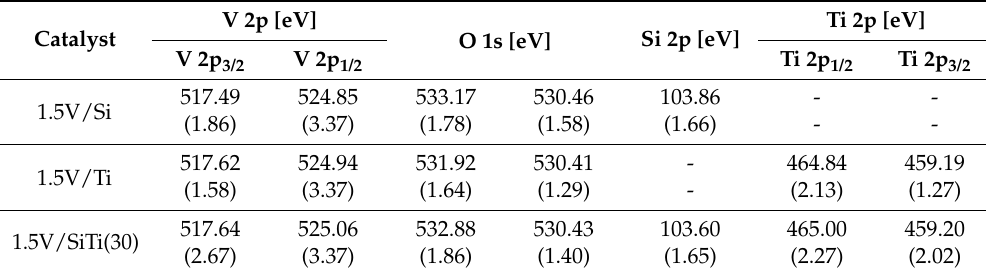
Table 2. Binding energies and full width at the half-maximum (FWHM) values presented in the brackets for the fresh 1.5%V 2 O 5 catalysts supported on SiO 2 , TiO 2 and SiTi(30).